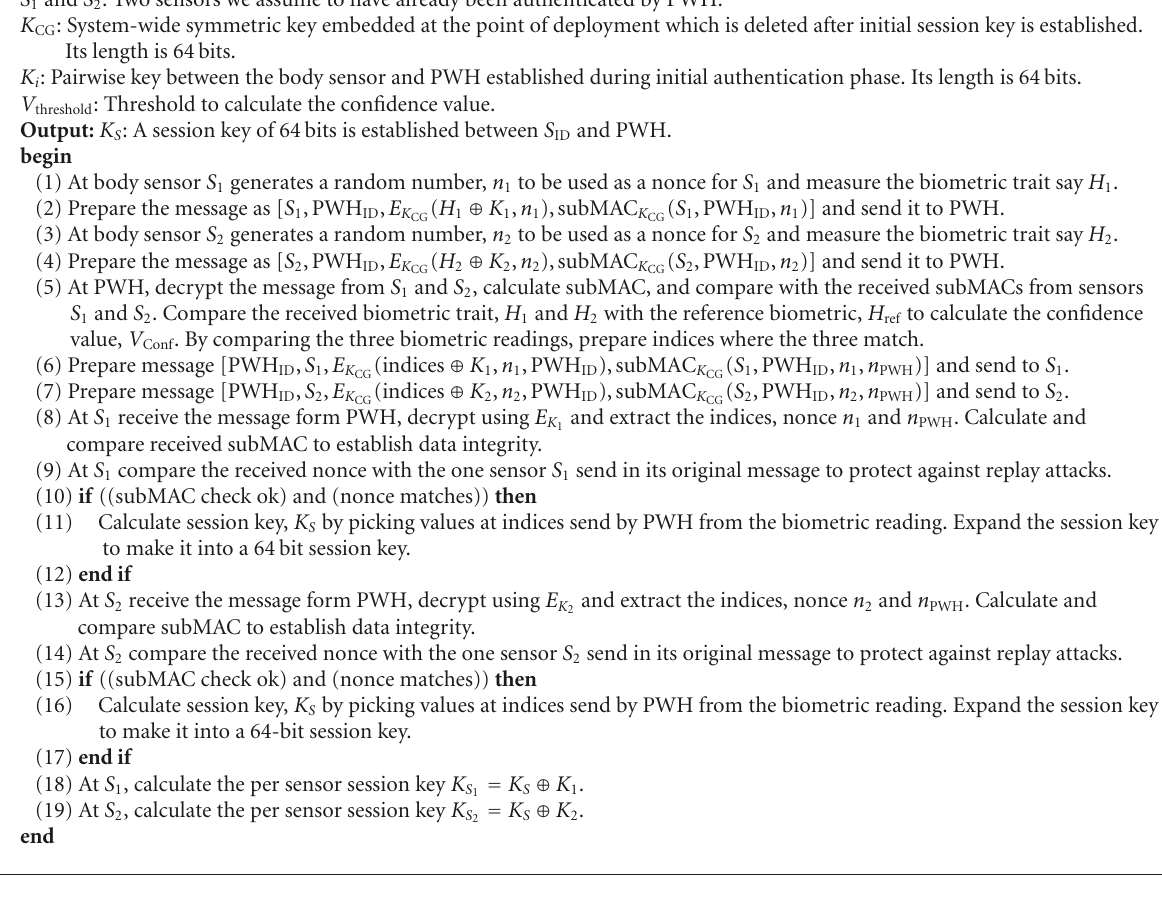
Algorithm 5: SKEA: symmetric session key